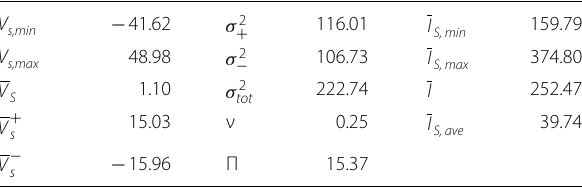
Table 8 Computed molecular surface properties (ESP) and (ALIE) of